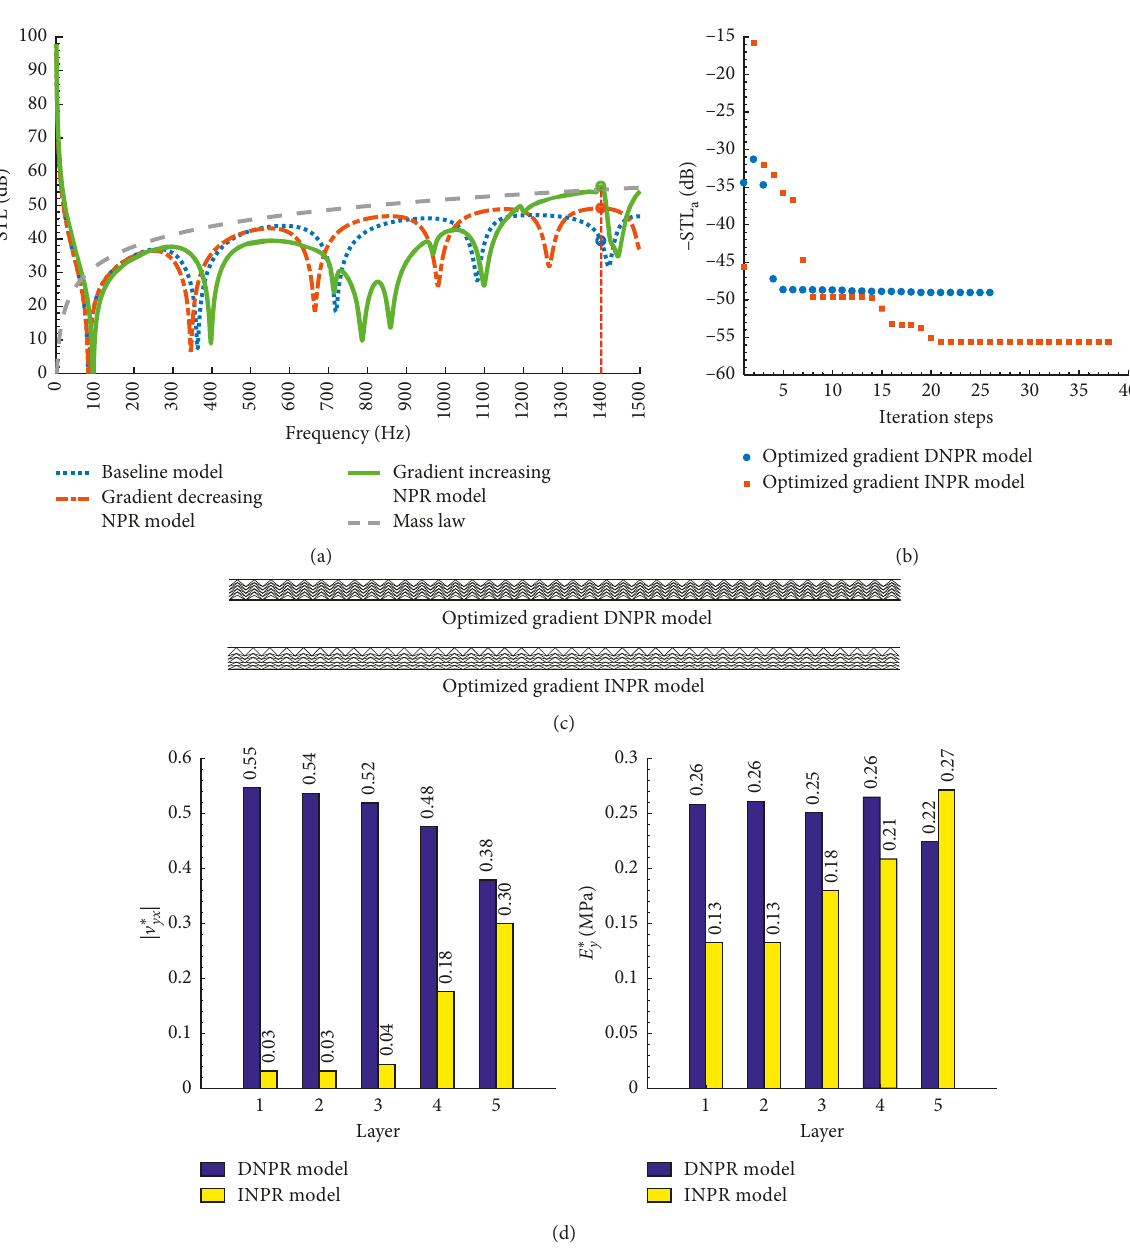
Figure 14: Optimal design at 1400Hz: (a) STLs of the baseline and optimized models; (b) iteration steps; (c) configurations of the optimized gradient NPR models; (d) mechanical properties of the DAHs in the optimized gradient NPR models. Table 2: Characteristic parameters of the baseline and optimized models for optimal design at 1400Hz.